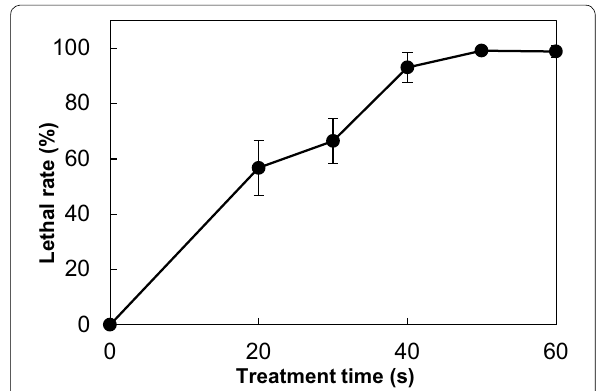
Fig. 2 Lethal rate of S. mobaraensis by ARTP mutagenesis